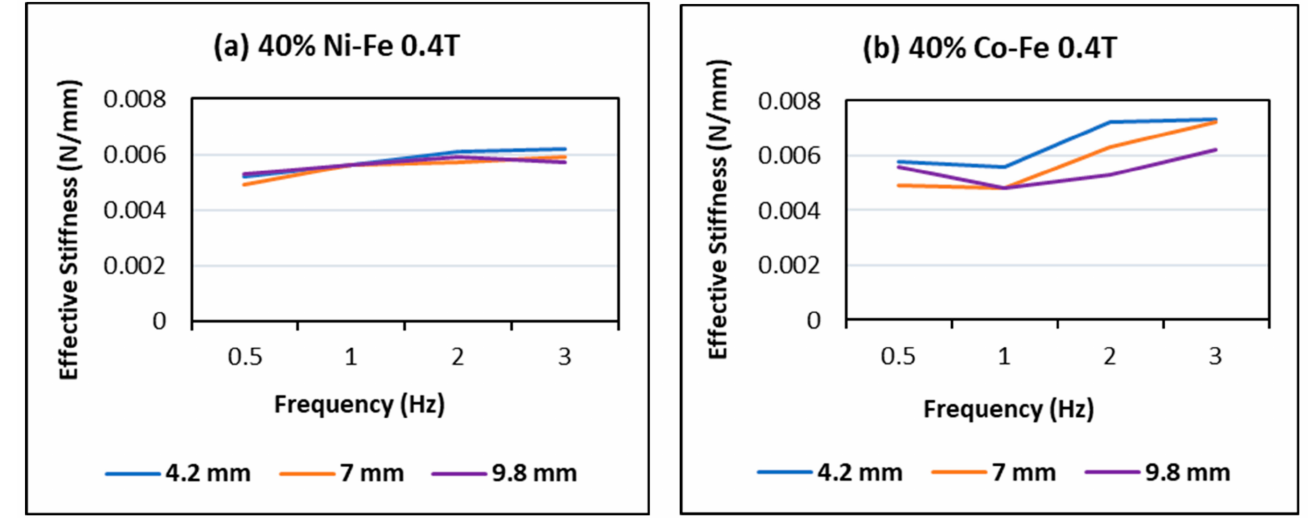
Figure 11. Effect of frequency and amplitude on effective stiffness at 40% filler content and 0.4 T magnetic field on ( a ) Ni-Fe MRE and ( b ) Co-Fe